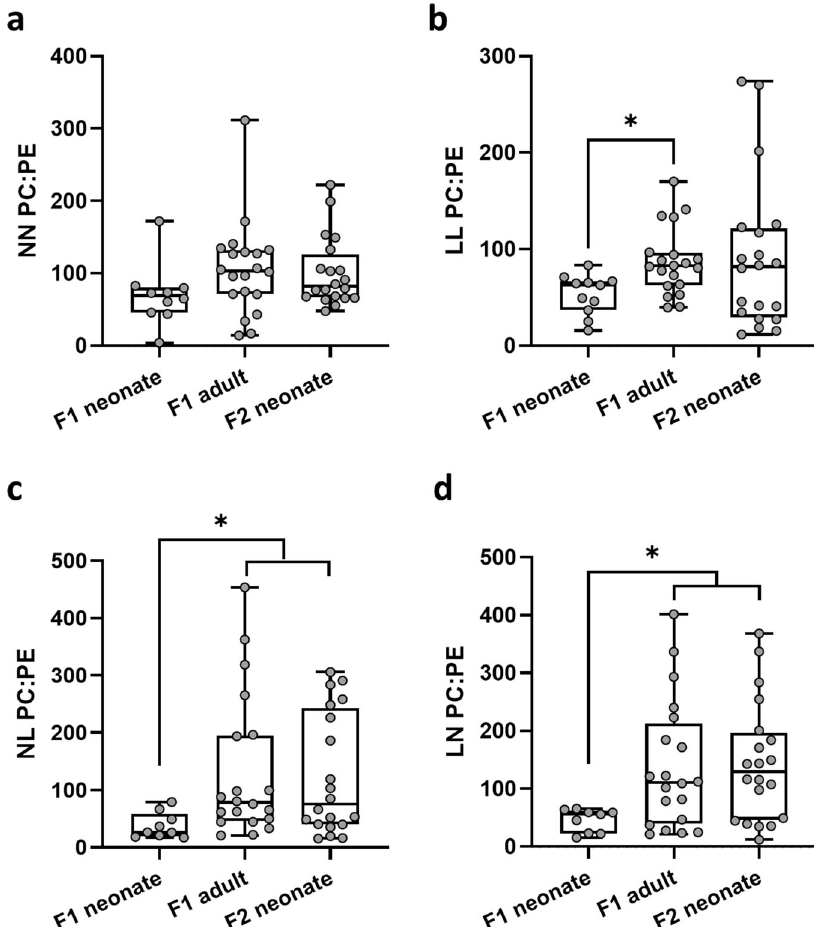
Fig. 6 Comparison of serum lipid abundance pro fi les across generations. Relative hepatic phosphatidylcholine:phosphatidylethanolamine (PC:PE) ratio in a NN (NPD sperm and NPD seminal plasma) F1 neonatal, F1 adult and F2 neonatal offspring, b LL (LPD sperm and LPD seminal plasma) F1 neonatal, F1 adult and F2 neonatal offspring, c NL (NPD sperm and LPD seminal plasma) F1 neonatal, F1 adult and F2 neonatal offspring and d LN (LPD sperm and NPD seminal plasma) F1 neonatal, F1 adult and F2 neonatal offspring. N = 4 – 10 males and females per treatment group, selected from all the litters generated. ∗ p < 0.05. Statistical differences were determined using one-way ANOVA with Bonferoni post hoc